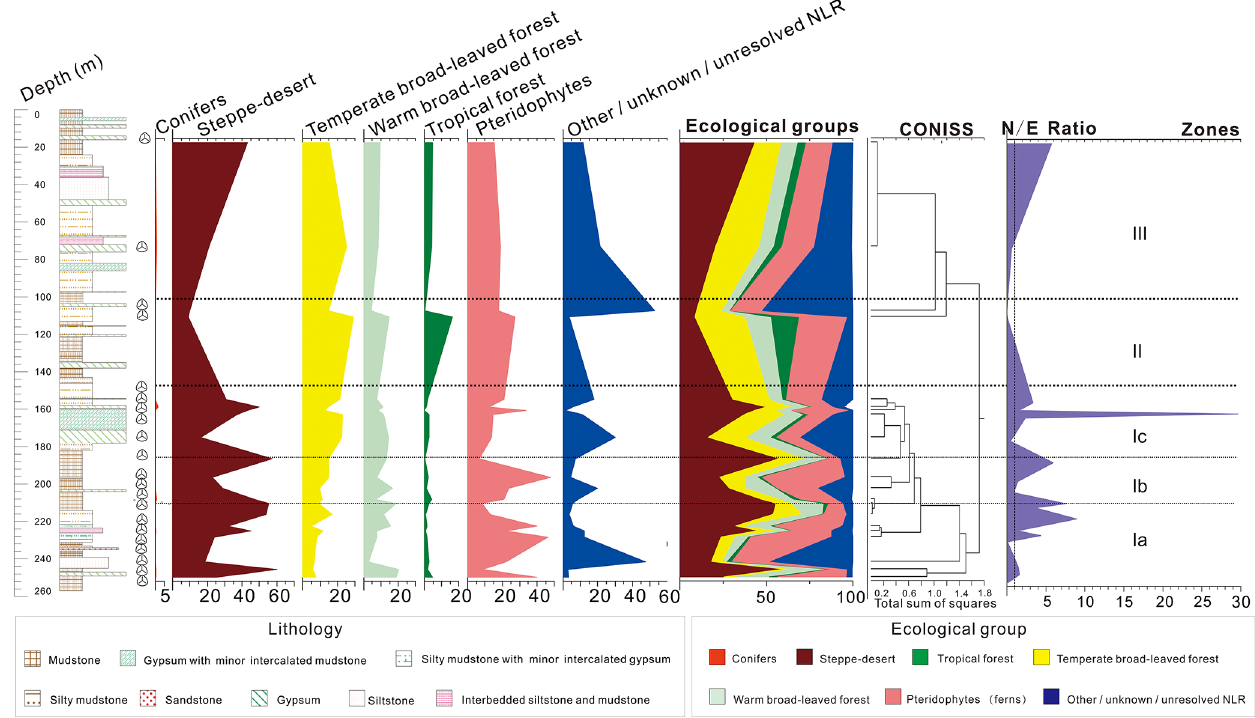
Figure 3. Cumulative pollen summary diagram of the Ria Zhong (RZ) section in the Nangqian Basin, Yushu area, Tibet, with palynomorph percentages of the total pollen sum plotted on the x axis as well as zones and subzones based on CONISS ordinations. Pollen taxa are grouped into plant functional types (PFTs) according to their correspondence with nearest living relatives (NLR), indicated in the legend. Some taxa have multiple or unresolved botanical affinities and are, therefore, assigned to the “Other/unknown/unresolved NLR” group. Productive horizons are indicated by a small trilete spore to the right of the simplified section log. The Nitraria/Ephedra ( N/E ) pollen ratio is plotted in purple, with a dashed line indicating the transition point between desert/semi-desert ecosystems ( < 1) and steppe–desert ( >